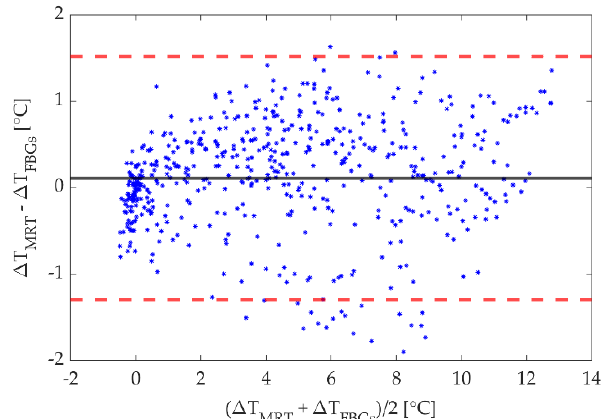
Figure 10. Bland-Altman analysis results for measurements performed on agar gel phantom. The LOA (dotted red lines) and the MOD (black line) are shown.